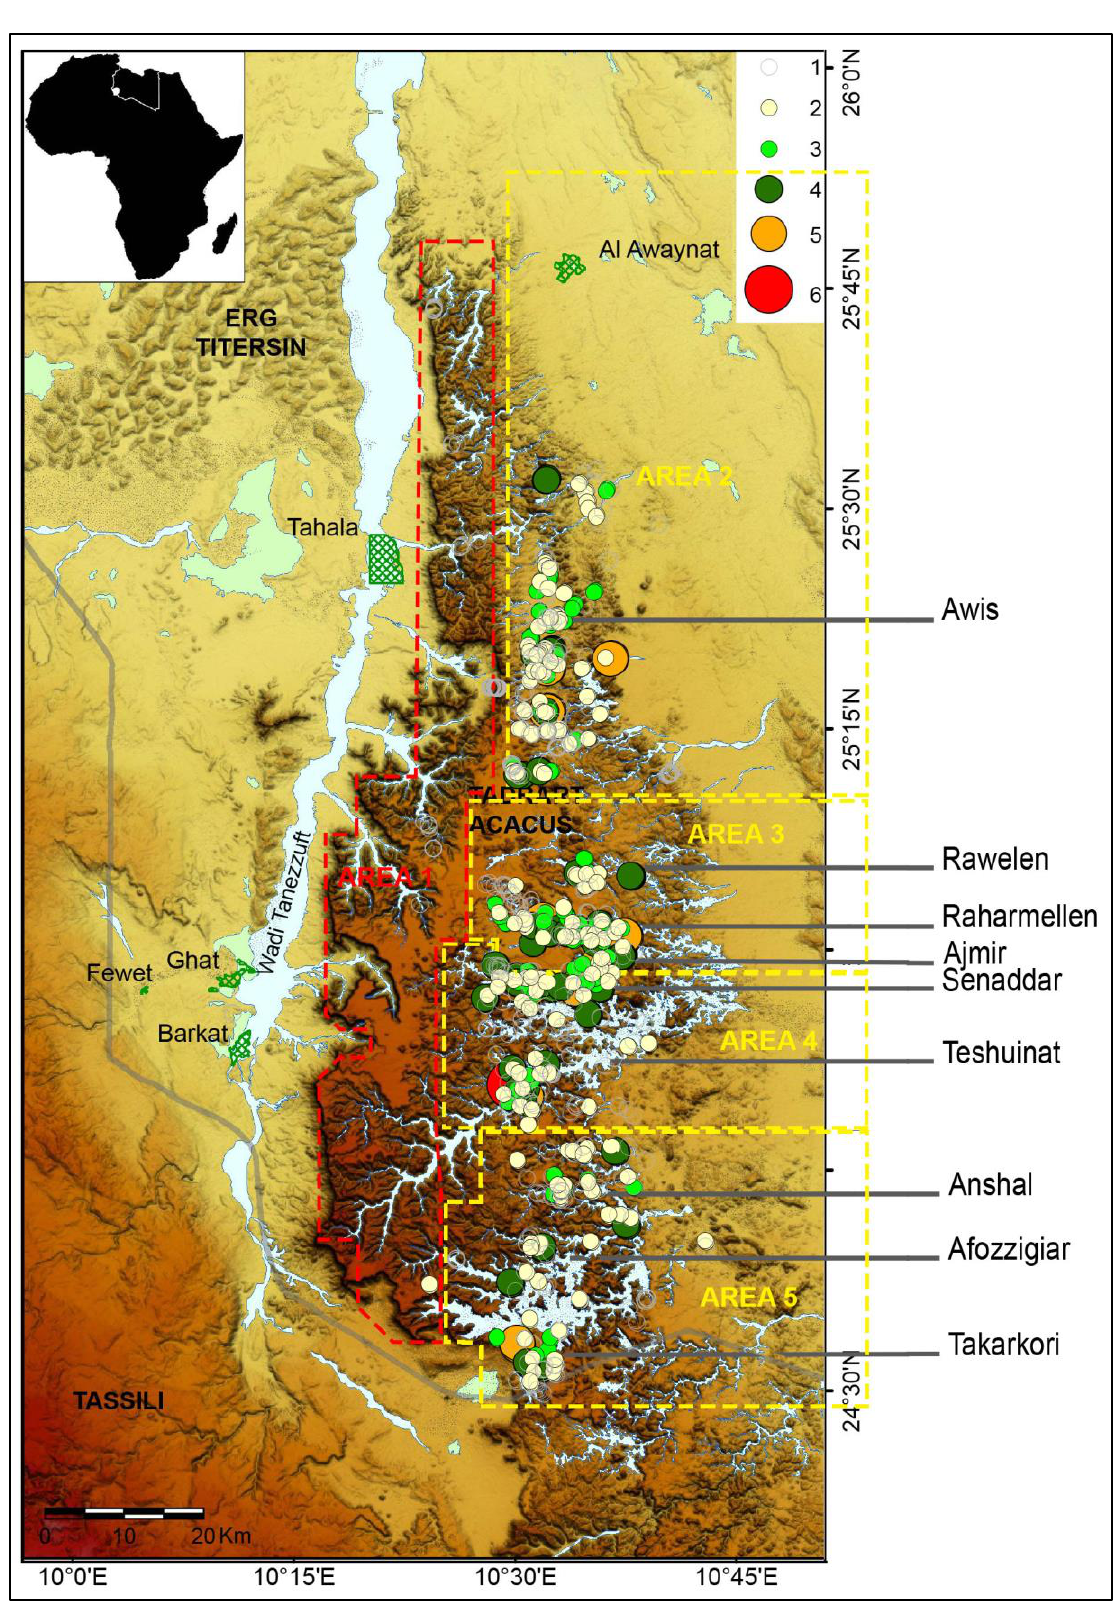
Figure 10. Map of Tadrart Acacus with the distribution of rock art sites, marked as dots scaled by the number of rock art styles present in the site; the five areas used in the analysis have been